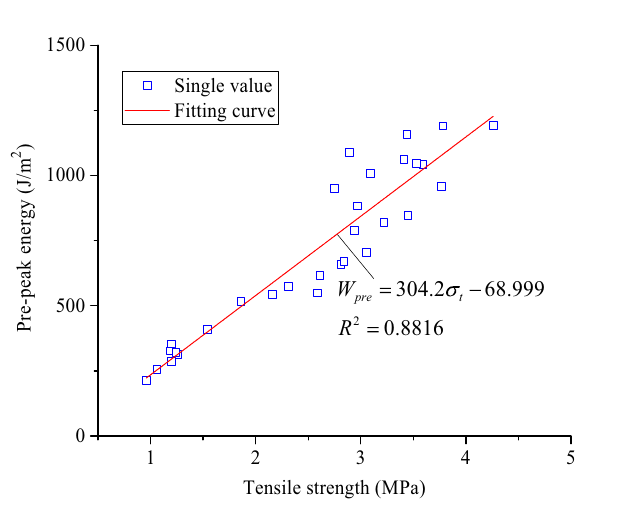
Figure 13. The relationship between the tensile strength and the longitudinal wave velocity.